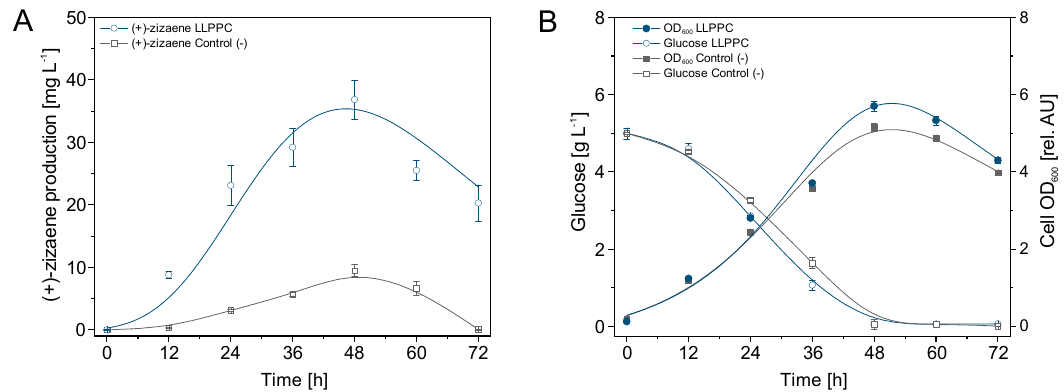
Figure 3. Comparison of the (+)-zizaene production ( A ) and growth kinetics ( B ) between the liquid-liquid phase partitioning cultivation (LLPPC ) and the control (-) without extractant from the E. coli TZS+MevZS strain. Plots correspond to the mean of three independent experiments with error bars as SD.